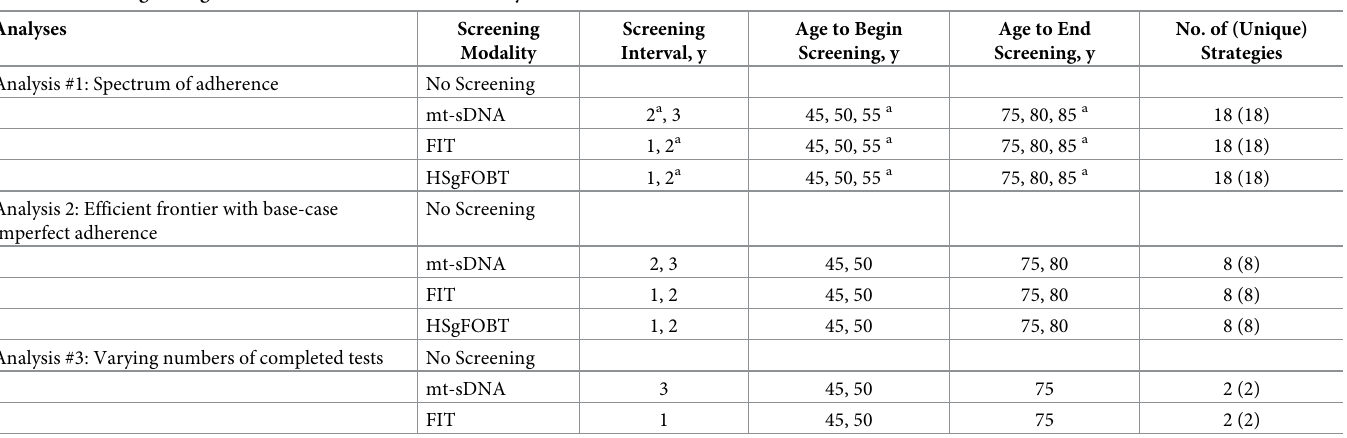
Table 1. Screening strategies evaluated for each adherence